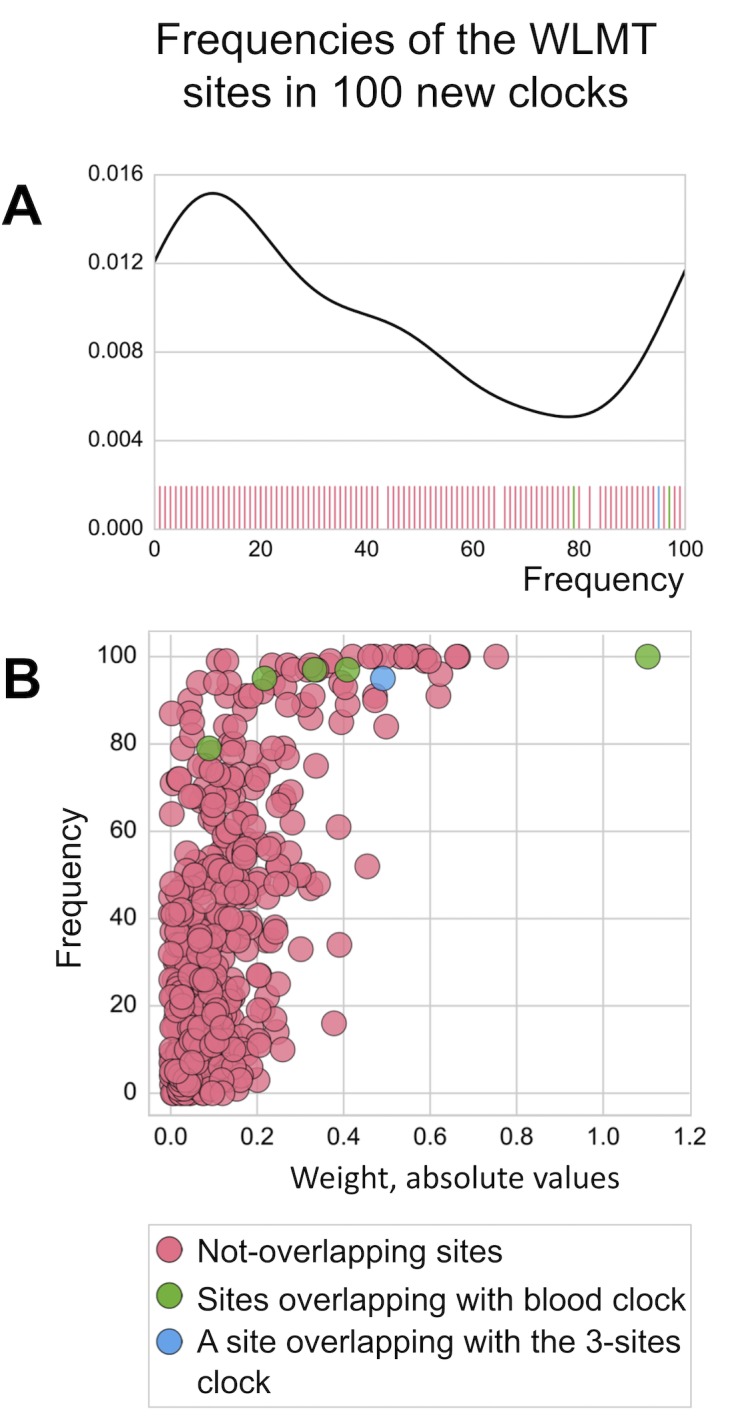
Frequency of the occurrence of WLMT clock sites in 100 clocks generated based on the robustness study.100 clocks are trained on different subsets of the set of samples used in WLMT construction. (A) Density plot showing the overall distribution of frequencies of WLMT clock sites as found in the generated 100 clocks. Carpet plot shows the exact values of frequencies. (B) Relation of the absolute values of weight of sites in the WLMT clock and frequency of these sites in the 100 alternative clocks.